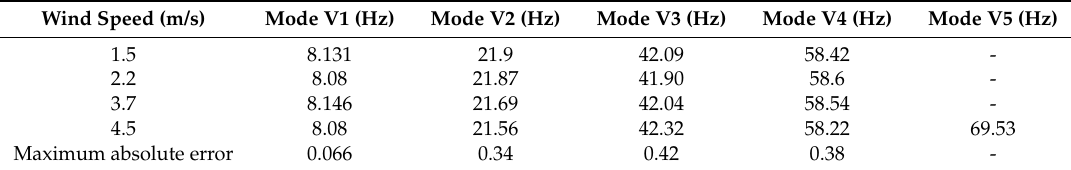
Table 4. Natural frequencies calculated by stochastic subspace identification (SSI).